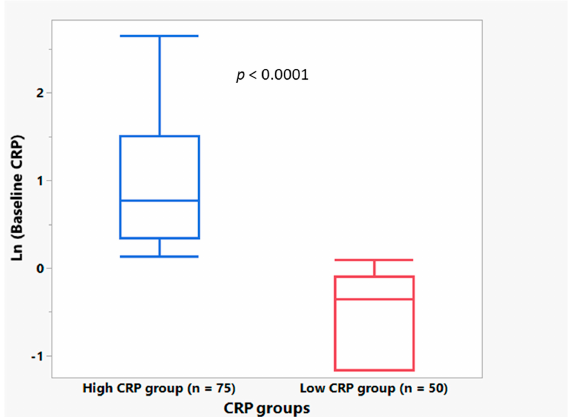
Figure 2. Box and Whisker plots depicting the distribution of baseline plasma CRP values for the high CRP group (CRP ≥ 1.13 mg/L) ( n = 75 patients, in blue) and the low CRP group (CRP < 1.13 mg/L) ( n = 50 patients, in red) where the bottom of the box depicts the first quartile of the data, the solid line through the box represents the median, and the top of the box depicts the third quartile of the data. The ends of the “whiskers” depict the maximum and minimum values. Results show that median baseline CRP value was statistically significantly higher in the high CRP group compared with the low CRP group (Wilcoxon test, p < 0.0001).